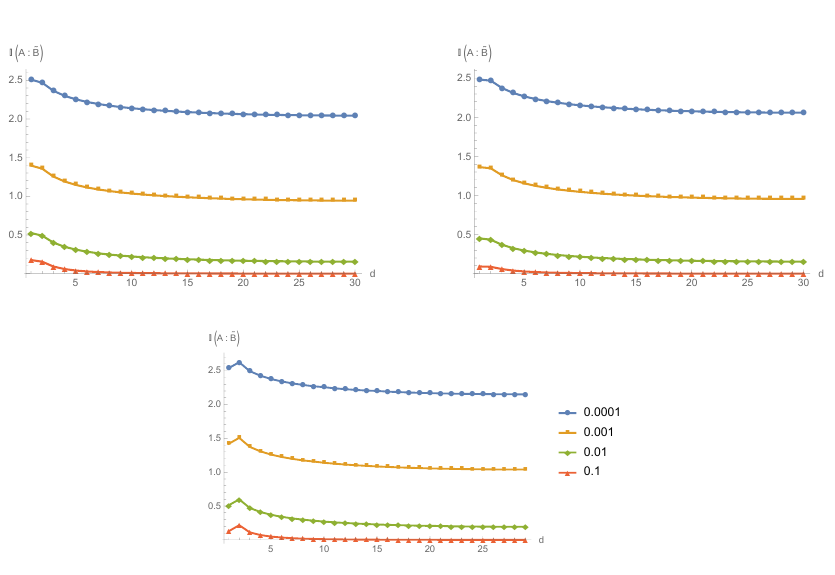
Figure 14 . The left, central and the right one show I ( A : ~ B ) for j A j = j B j = 1 , j A j = 1 ; j B j = 2 and j A j = j B j = 2 respectively, each for m=0.0001,0.001,0.01,0.1 indicated by di(cid:11)erent colors in each of the plots.